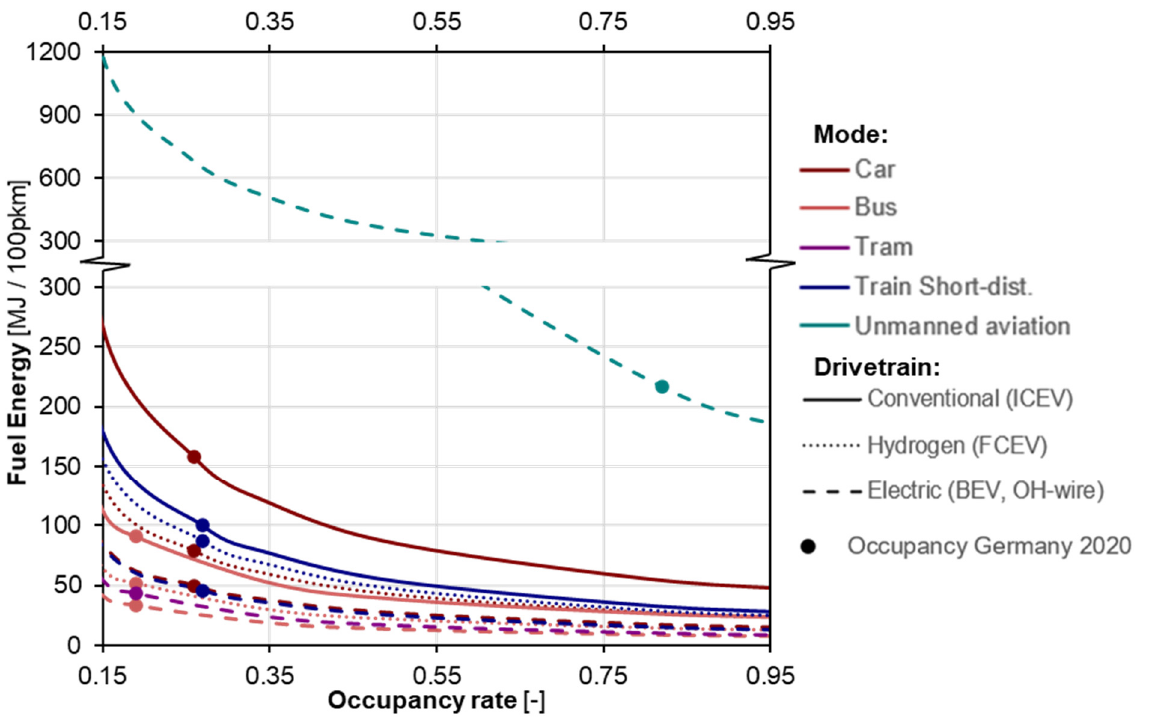
Figure 11. Fuel energy demand vs. occupancy rate for selected short-distance passenger modes.